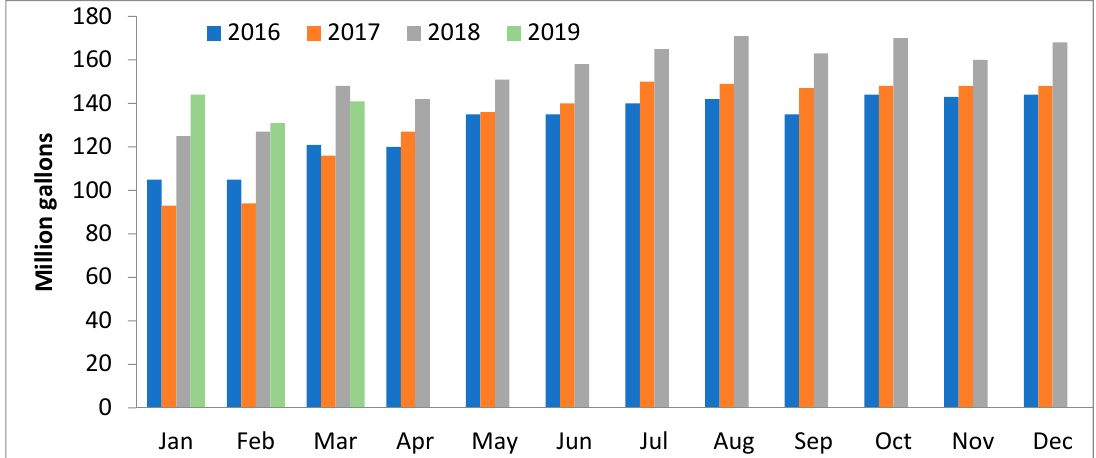
Figure 2. U.S. monthly biodiesel production 2016–2019 [13].